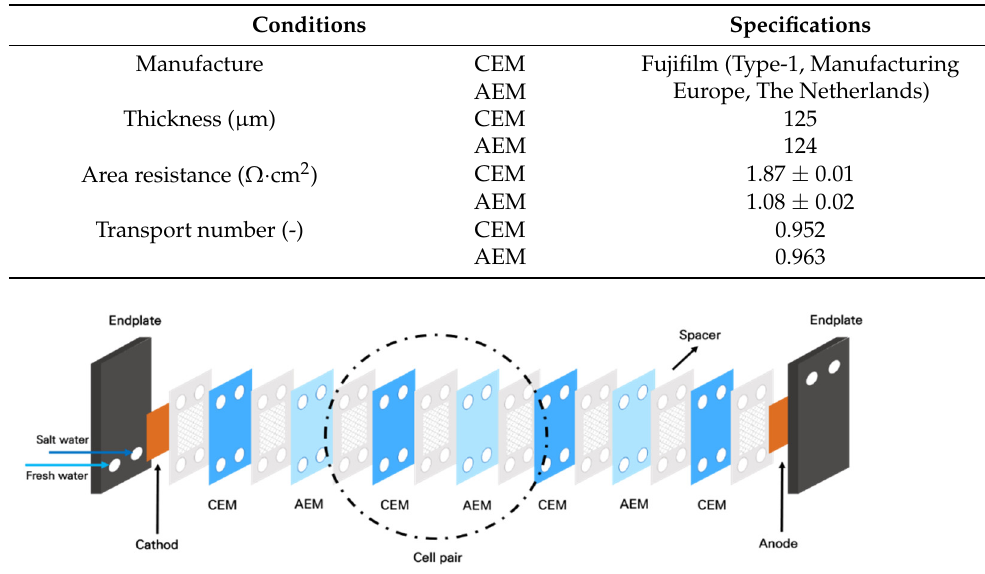
Table 2. Experimental conditions for membrane fabrication.